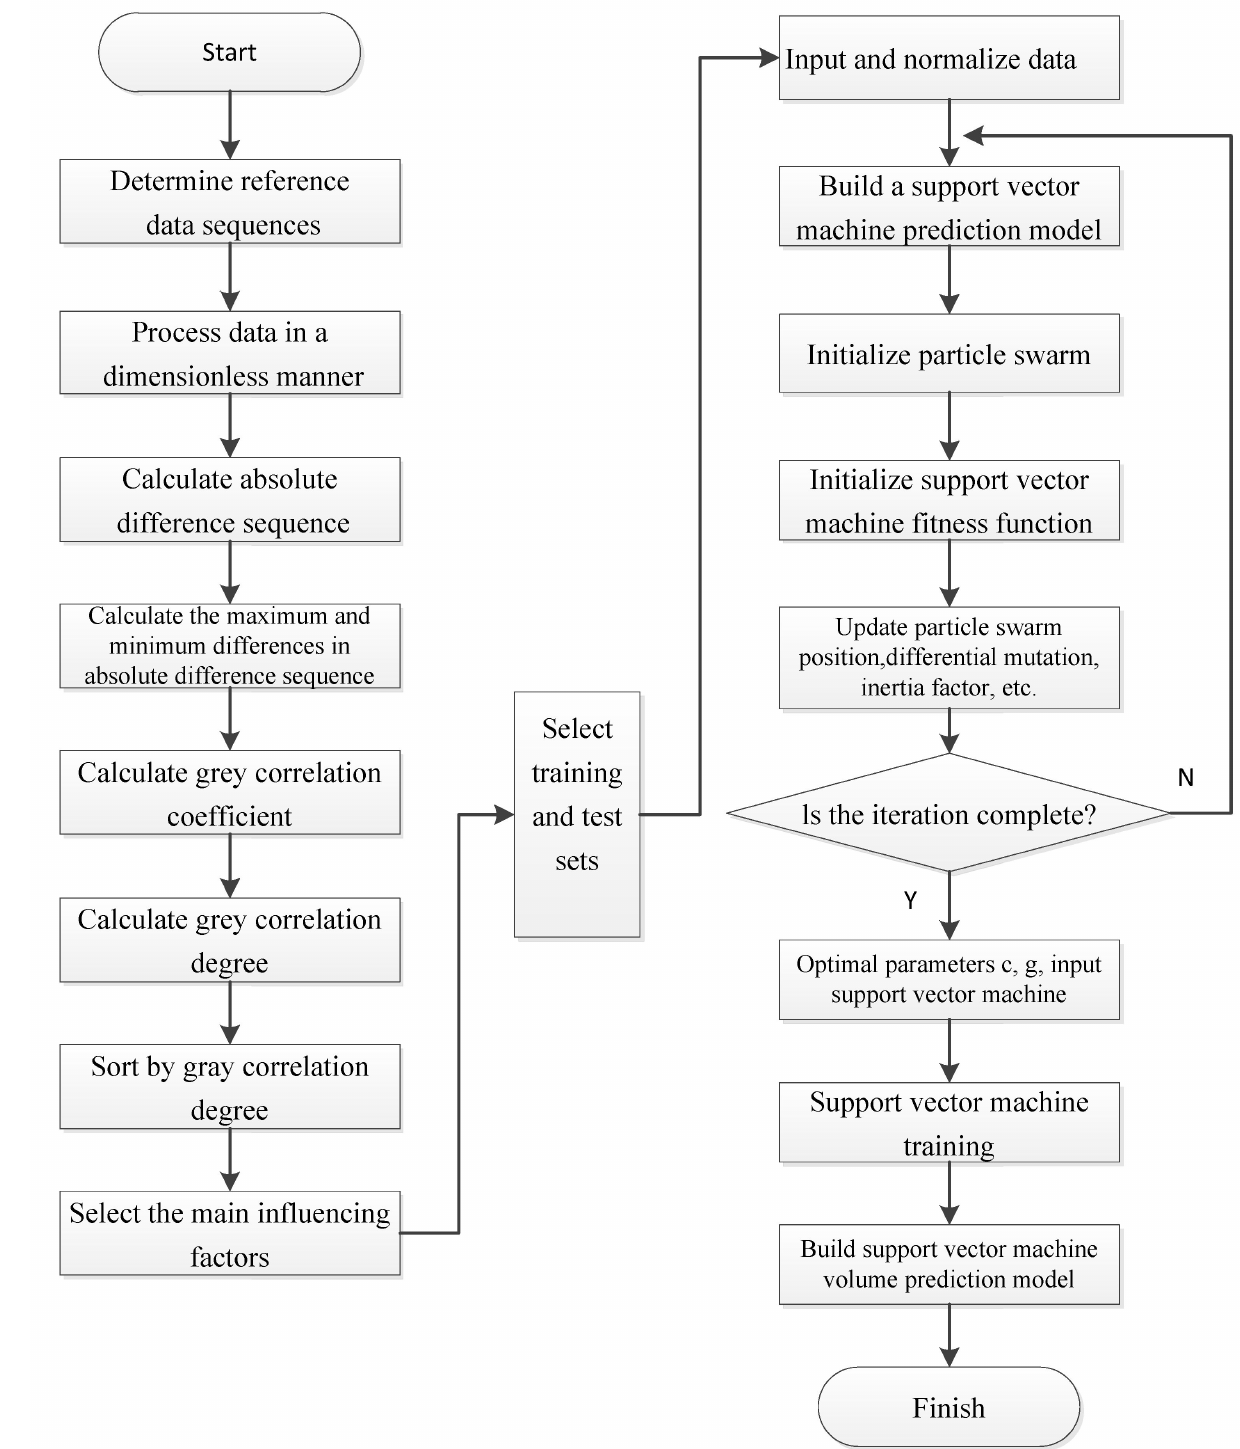
Figure 2. Flowchart of GRA-PSO-SVM model. β has the ability to balance local and global searches. The larger the value of β , the stronger the global-convergence ability; otherwise, it has a stronger local-convergence ability. The learning factors c 1 and c 2 control the ability of the particle to find the